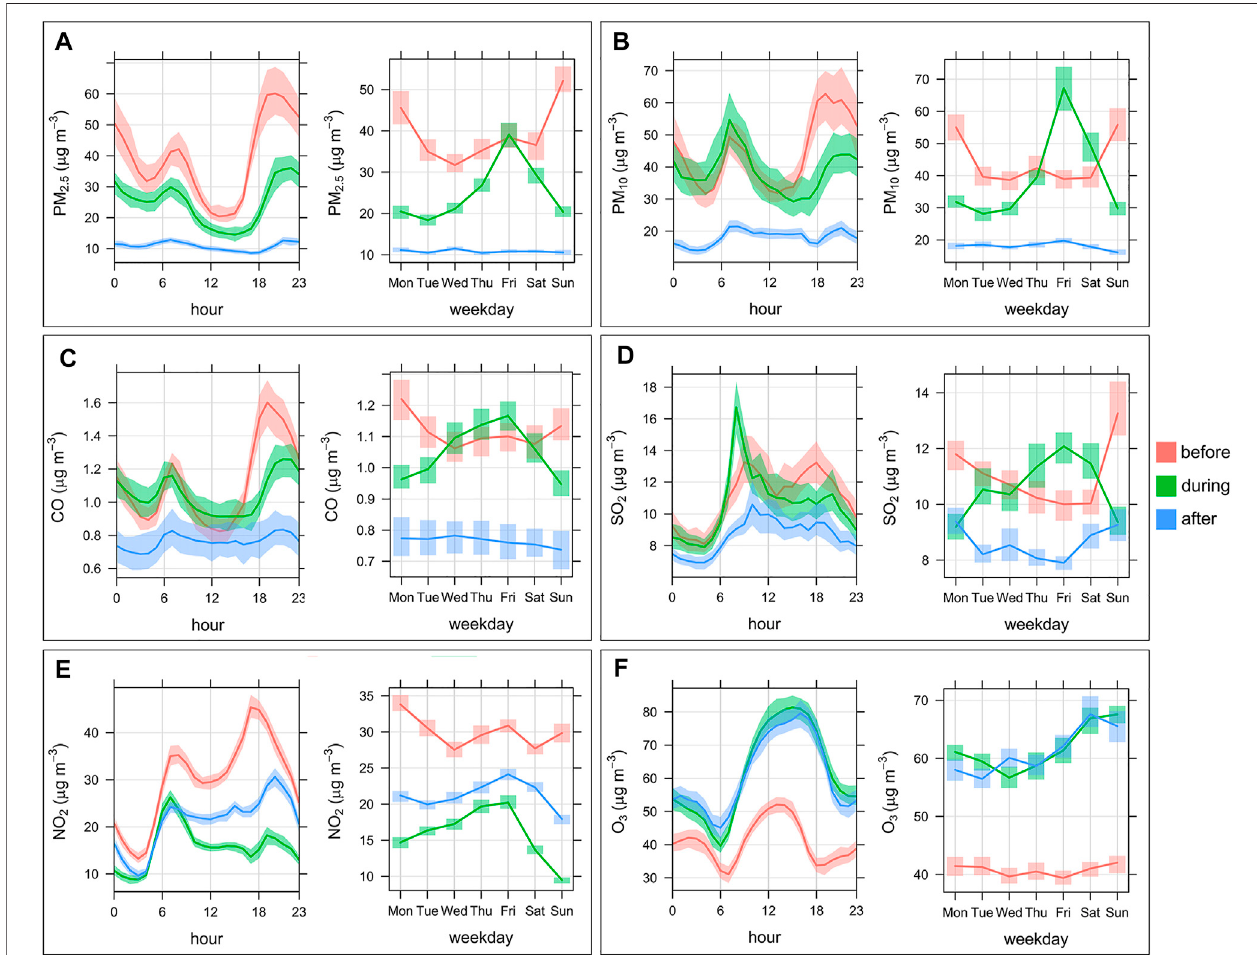
FIGURE 5 | Hourly and weekly cycles of pollutants concentrations in Serbia before (BRM), during (RM), and after the restrictive measures (ARM) periods for (A) PM2.5, (B) PM10, (C) CO, (D) 2 , (E) NO 2 , and (F) O 3 .